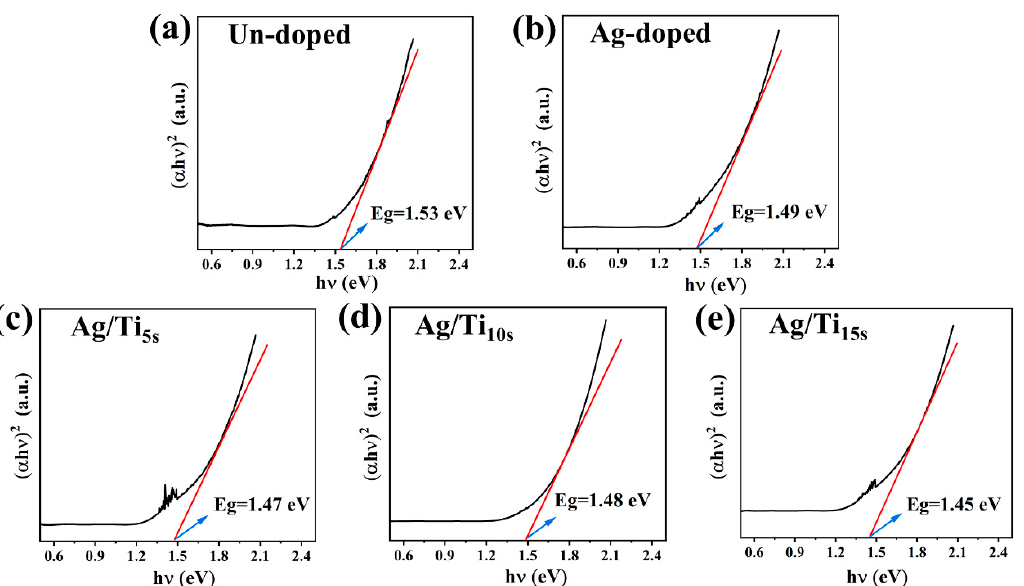
Figure 4. ( a – e ) The relationship between ( α h ν ) 2 and h ν for Ag/Ti co-doped CoSb 3 , the un-doped and single Ag-doped thin films.